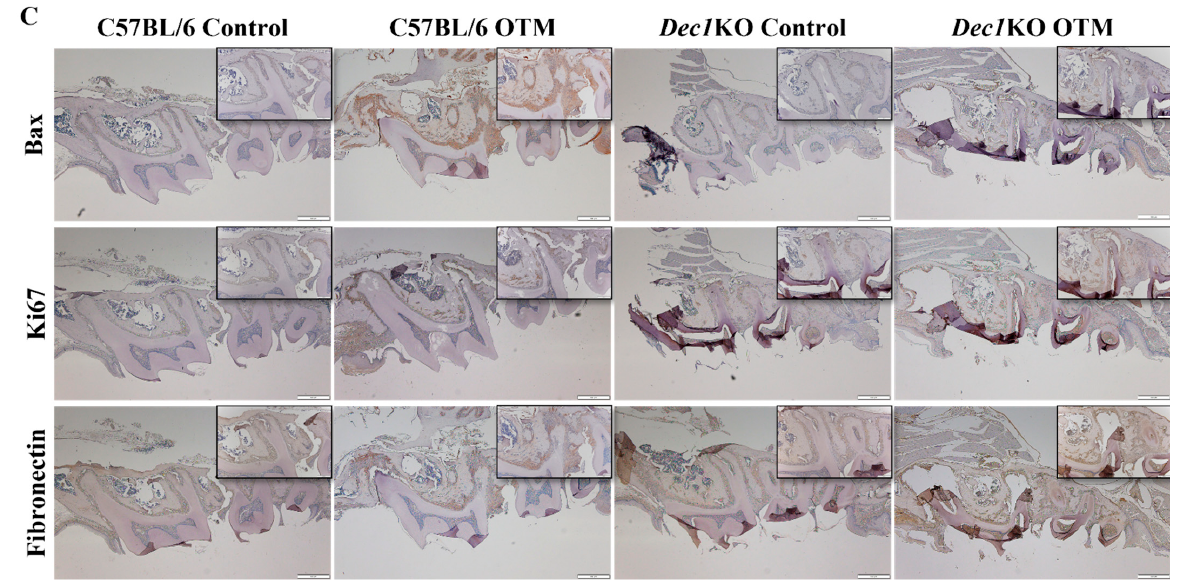
Figure 8. Dec1 deficiency attenuates tooth movement, ribosomal protein regulation, and inflammation in the OTM mouse model. ( A ) H-E staining of WT OTM mice shows a wider distance between the first and second maxillary molars compared to Dec1 KO mice during orthodontic treatment. ( A , B ) Expression levels of ribosomal proteins and IL-1 β were decreased in Dec1 KO OTM mice compared with WT OTM mice. Scale bars = 500 μ m. All results are representative of at least three independent experiments. ( C ) Bax expression was decreased in Dec1 KO OTM mice compared with WT OTM mice. Ki67 and fibronectin expression were increased in Dec1 KO OTM mice. Scale bars = 500 μ m. All results are representative of at least three independent experiments. C, compression. T, tension.